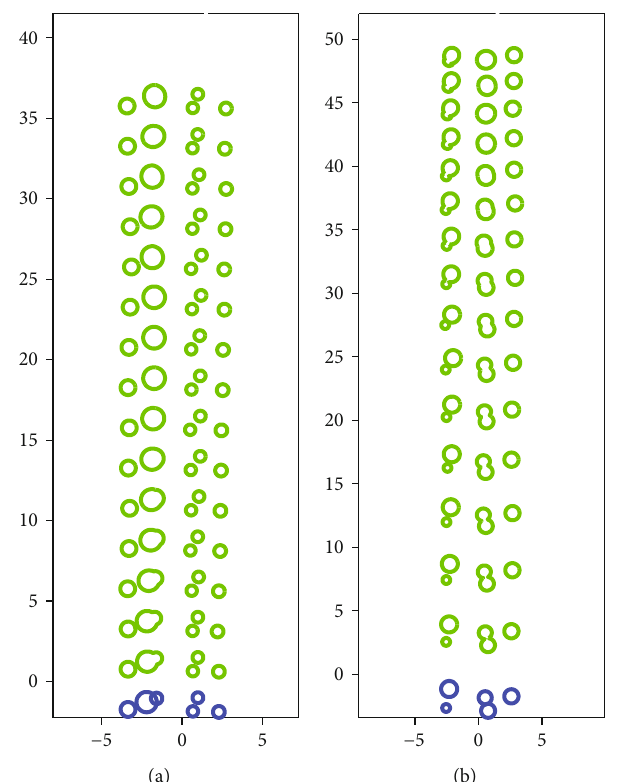
/ dt = 0 ). (b) 5 bubbles with variable speed ( dv y